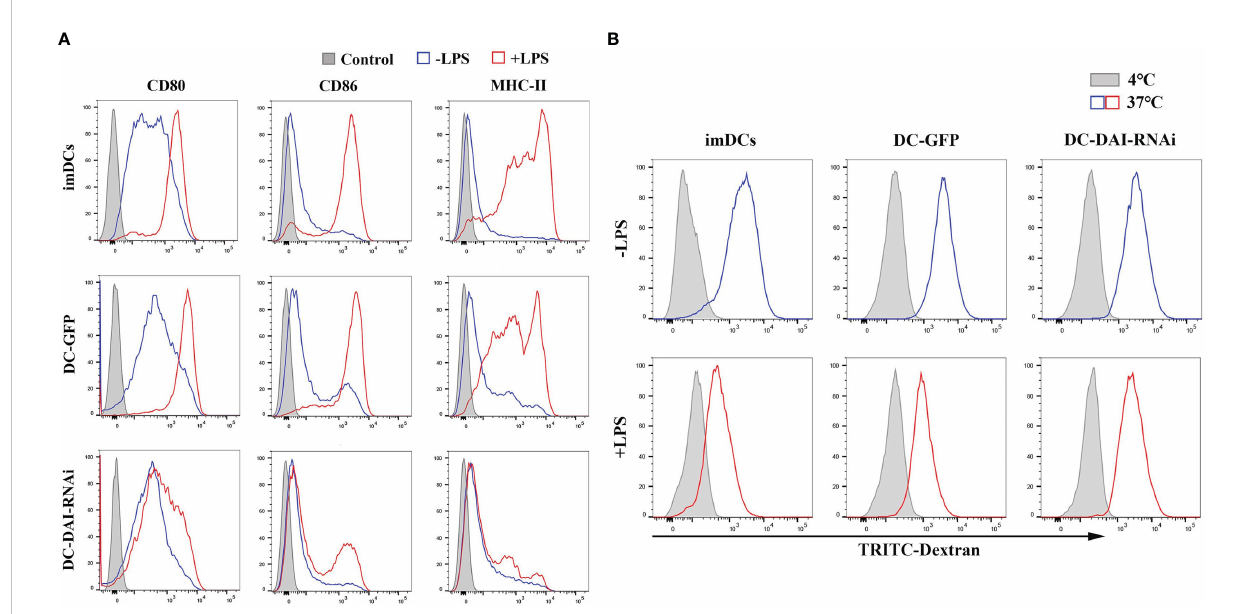
FIGURE 2 DC-DAI-RNAi inhibited the expression of major co-stimulatory molecules (CD80 and CD86) and MHC-II. (A) Puri fi ed imDCs, DC-GFP and DC-DAI- RNAi were stained with fl uorescence-conjugated CD80, CD86 and MHC-II monoclonal antibodies. The expression of major co-stimulatory molecules (CD80 and CD86) and MHC-II in DC-DAI-RNAi were signi fi cantly inhibited compared to those of imDCs and DC-GFP upon LPS stimulation (n=3). (B) DC-DAI-RNAi exhibited stronger phagocytic ability after LPS stimulation